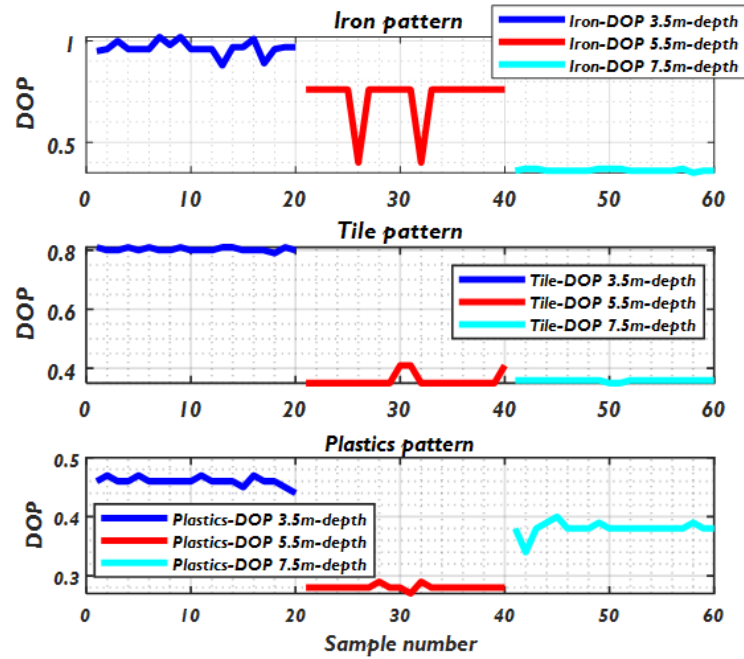
Figure 9. Comparison of the degree of polarization of different objects at different depths in water.